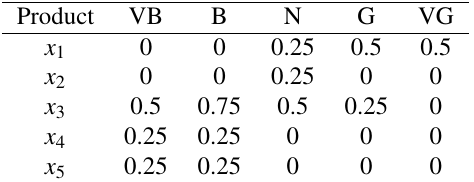
Table 4. The Relations among PR i and The Labels in La.